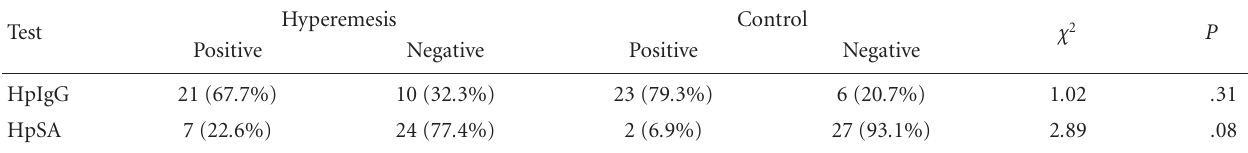
Table 2: Helicobacter pylori seropositivity and fecal antigen status in hyperemesis